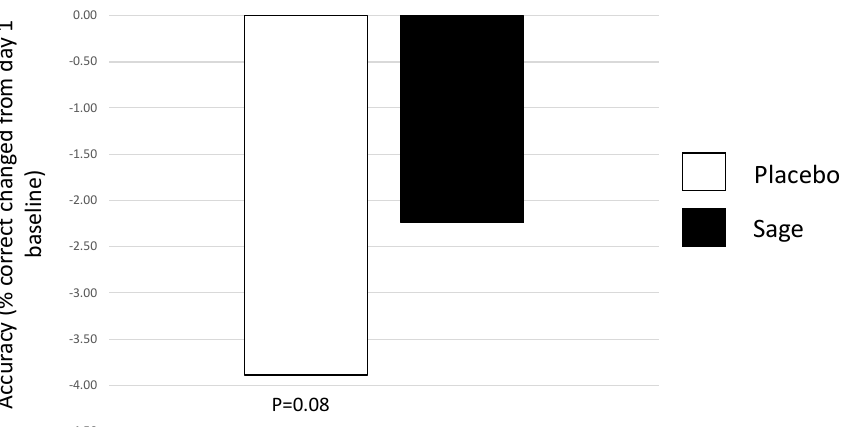
Figure 13. Pure chronic effect of treatment on day 29 for overall accuracy: a trend towards a significant pure chronic effect of treatment ( p = 0.08) was observed, where accuracy was significantly poorer (as compared to baseline performance on day 1) in the placebo condition as compared to the sage condition.